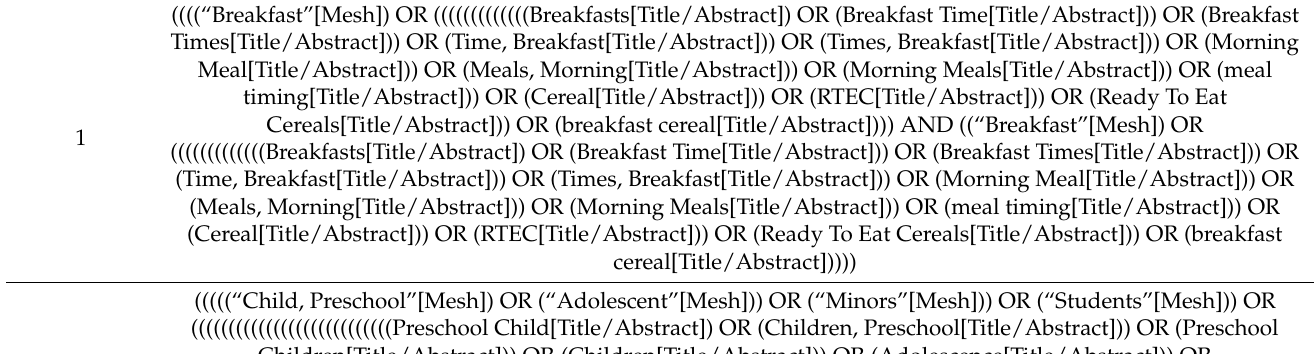
Table 2. Search strategy for